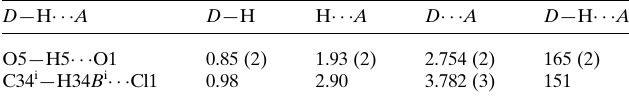
Table 1 Hydrogen-bond geometry (A˚ , (cid:5)